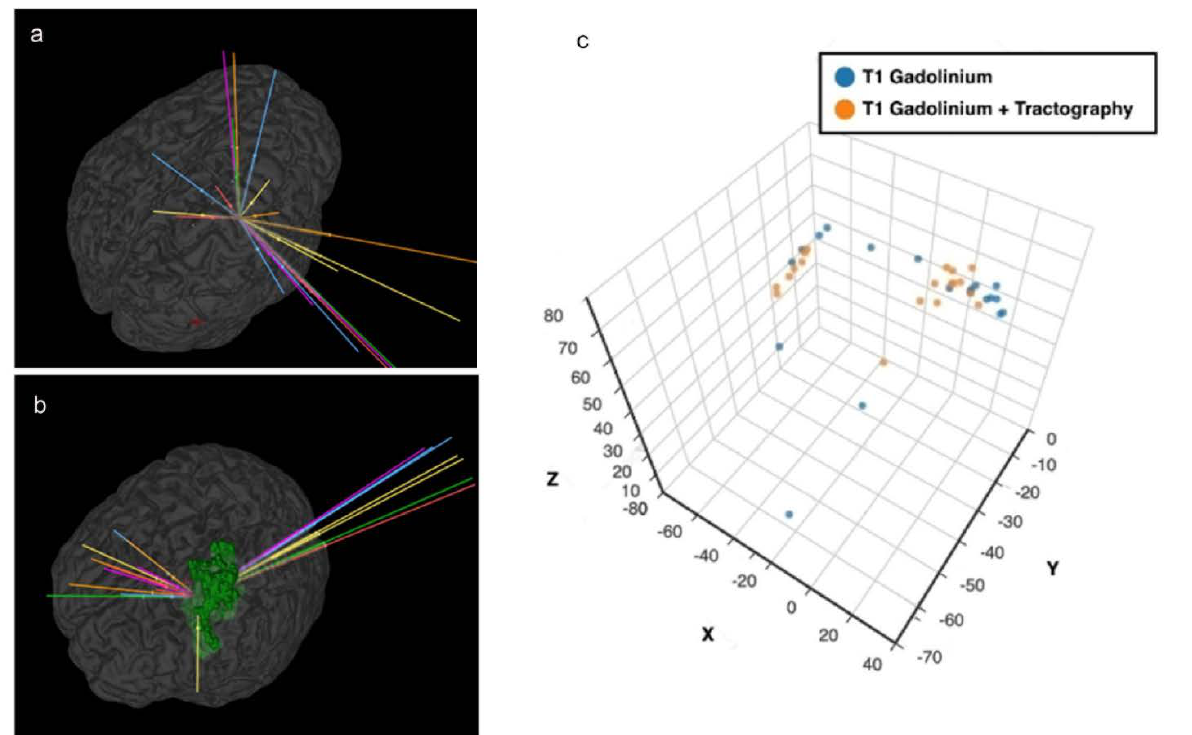
Figure 6. Proximity to midline and tractography. ( a ) Anatomy-based nBx—trajectories are scattered all over the hemisphere; ( b ) Tractography enhanced nBx—trajectories are pushed closer to midline in an intent to avoid CST; ( c ) Spatial representation of the cortical entry points of the different strategies based on X, Y and Z coordinates after definition of the line connecting the anterior and posterior commissures (AC-PC) and the middle commissural point